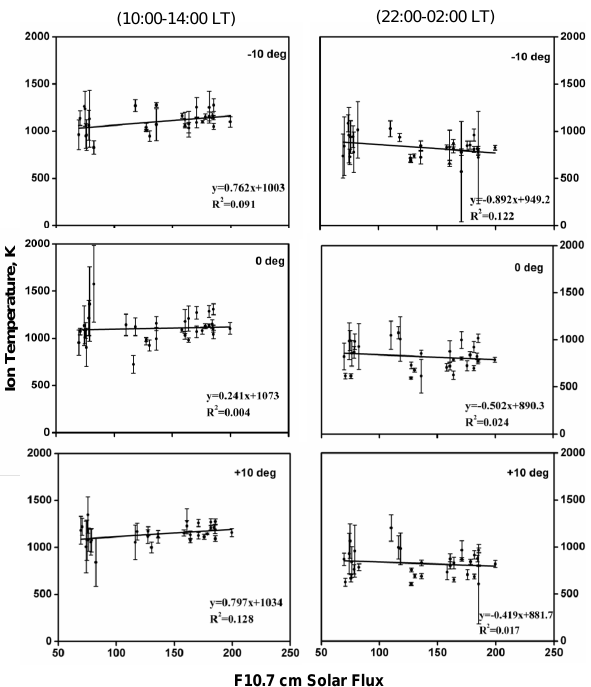
Fig. 3. Variation of monthly mean daytime and nighttime ion tem- perature with F 10 . 7 cm solar flux over − 10 ◦ , 0 ◦ and 10 ◦ magnetic latitudes. The data are averaged within ± 2.5 ◦ for the selected lati- tudes. Vertical bars about each point indicate one standard deviation from the mean.